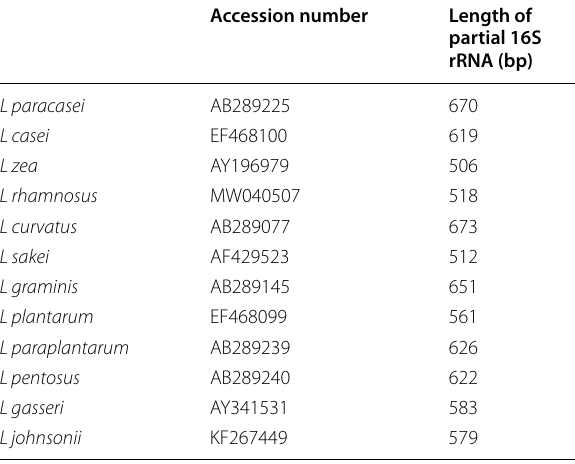
Table 1 Accession number and length of partial 16S rRNA